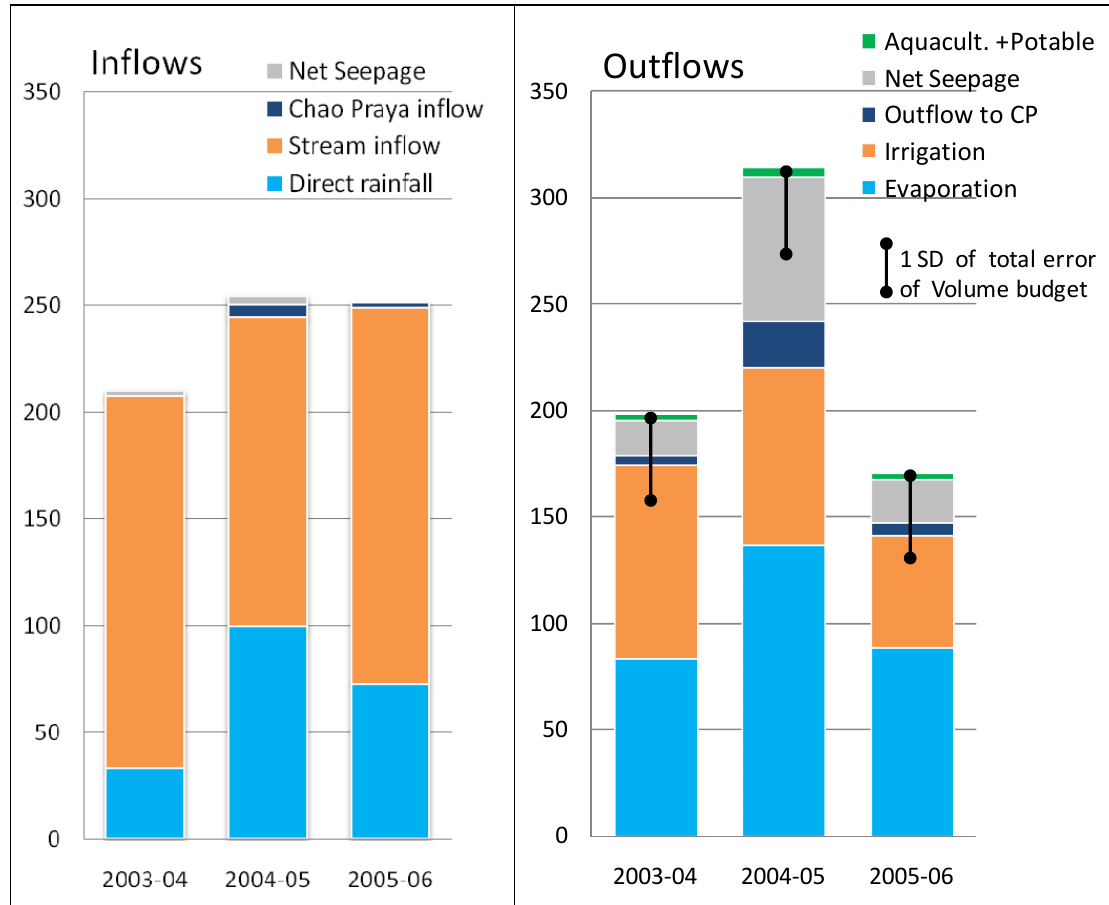
Figure 6. Volume of water (10 6 m 3 ) for water balance components over three